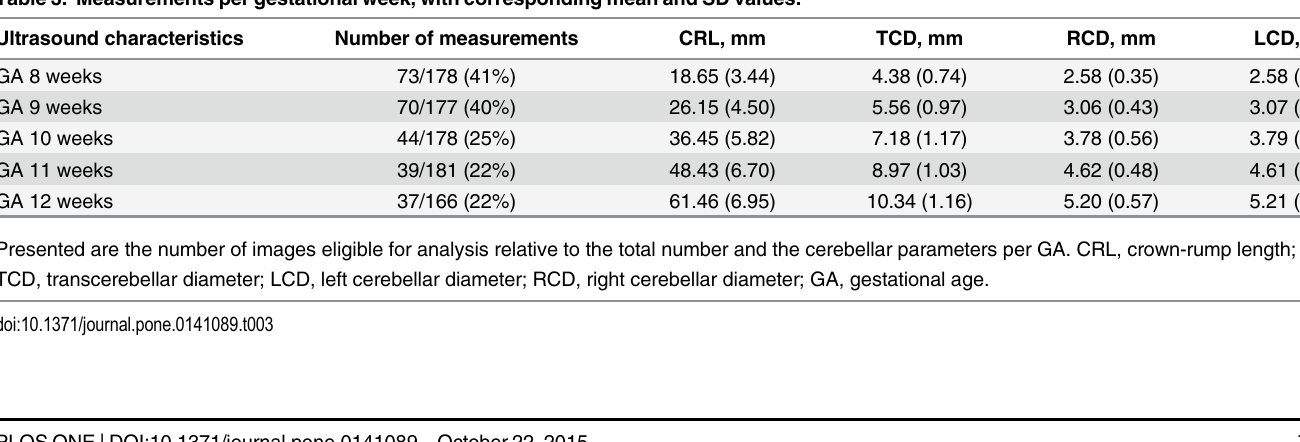
Table 4 depicts the results of both crude and adjusted linear mixed model analyses for all 3 cerebellar diameters and the proportional cerebellar growth trajectories by the timing of initia- tion of folic acid supplement use. Maternal age, mode of conception, periconceptional smok- ing, periconceptional alcohol use, ethnicity and the measurer were designated confounders in the final model. Subsequently, models for TCD, LCD, RCD and proportional growth (cerebel- lar diameters divided by CRL) were all adjusted for these final confounders. Both crude and adjusted linear mixed models showed small but significant effects on cerebellar size and pro- portional cerebellar growth by the timing of initiation of folic acid supplement use as function of CRL Repeating the same analysis for all cerebellar diameters and the timing of folic acid sup- plement use initiation as a function of GA, no significant differences were observed in either crude or adjusted models. Both crude and adjusted models showed significantly increased pro- portional cerebellar growth for all three cerebellar diameters when folic acid supplement use was initiated preconceptionally. In Fig 2 we graphically display the results of the adjusted linear mixed models as regression lines. The coloured area represents the ninety-five percent prediction interval for both lines. Comparable results for the right and left cerebellar hemisphere were depicted; therefore we only display the TCD and RCD graphs. There is a clear linear display of data points showing slightly increased cerebellar diameters as a function of CRL for TCD (A) and RCD (B). The lin- ear functions of preconceptional and postconceptional initiation of folic acid supplement use as function of GA cross for both the total (C) and unilateral (D) cerebellar diameters. Fig 2E